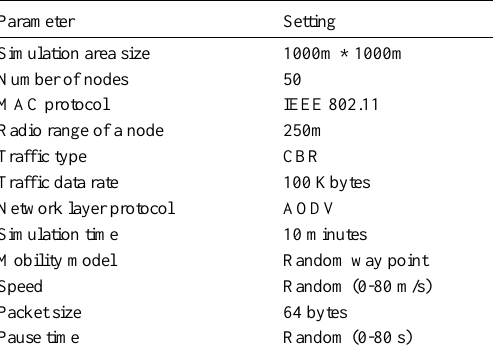
Table 1. Simulation